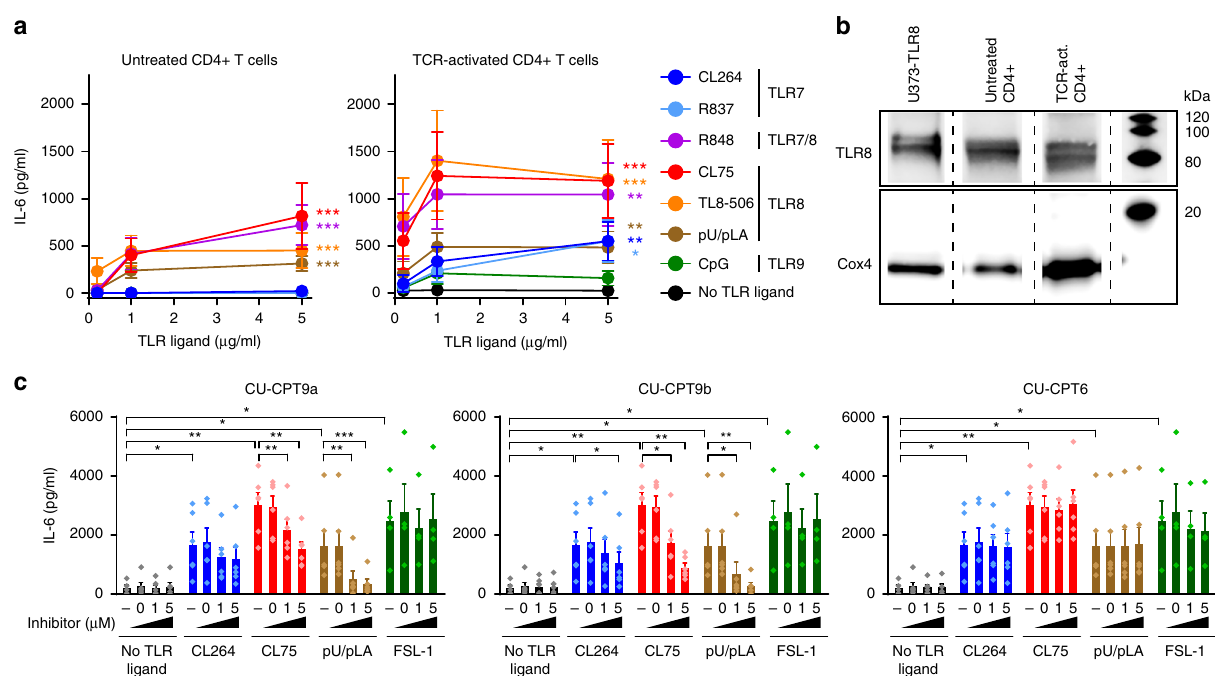
Fig. 2 TLR8 is expressed and induces secretion of IL-6 in human primary CD4 + T cells. a Untreated or TCR-activated human primary CD4 + T cells were stimulated with 0.2, 1, and 5 μ g/ml ligands to TLR7 (CL264, R837), TLR7/8 (R848), TLR8 (CL75, TL8-506, pU/pLA), or TLR9 (CpG, 0.2, 1, 5 μ M) for 24 h and IL-6 secretion was analyzed by ELISA. Data represent mean + SEM from four independent experiments. b TLR8 expression in untreated or TCR- activated CD4 + T cells was analyzed by immunoblotting. Lysates from U373 cells overexpressing human TLR8 were used as positive control and Cox4 as housekeeping control. c CD4 + T cells were untreated ( − ) or pre-treated with DMSO ( = 0), 1 or 5 μ M of TLR8-speci fi c inhibitors CU-CPT9a, CU-CPT9b, or the negative control compound CU-CPT6, for 2 h prior to TCR activation and stimulation with 5 μ g/ml CL264, CL75, pU/pLA, or FSL-1 (TLR2) for 24 h. IL-6 secretion was analyzed by ELISA. Bars represent mean + SEM from six independent experiments. Statistical signi fi cance was determined in a by calculating areas under the curve (AUC) followed by repeated measures one-way ANOVA with Dunnett´s post-test on log-transformed data, in c by two-way ANOVA with Dunnett ʼ s post-test; signi fi cance levels: * p < 0.05; ** p < 0.01; *** p < 0.001. Source data are provided as a Source Data